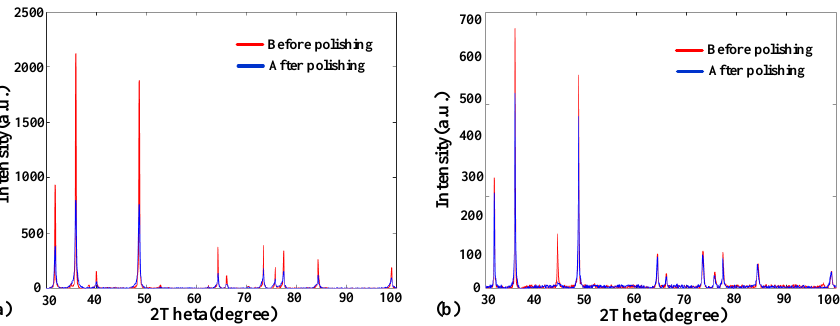
Figure 9. XRD results of typical areas of surface with ( a ) WC-0Co; ( b )